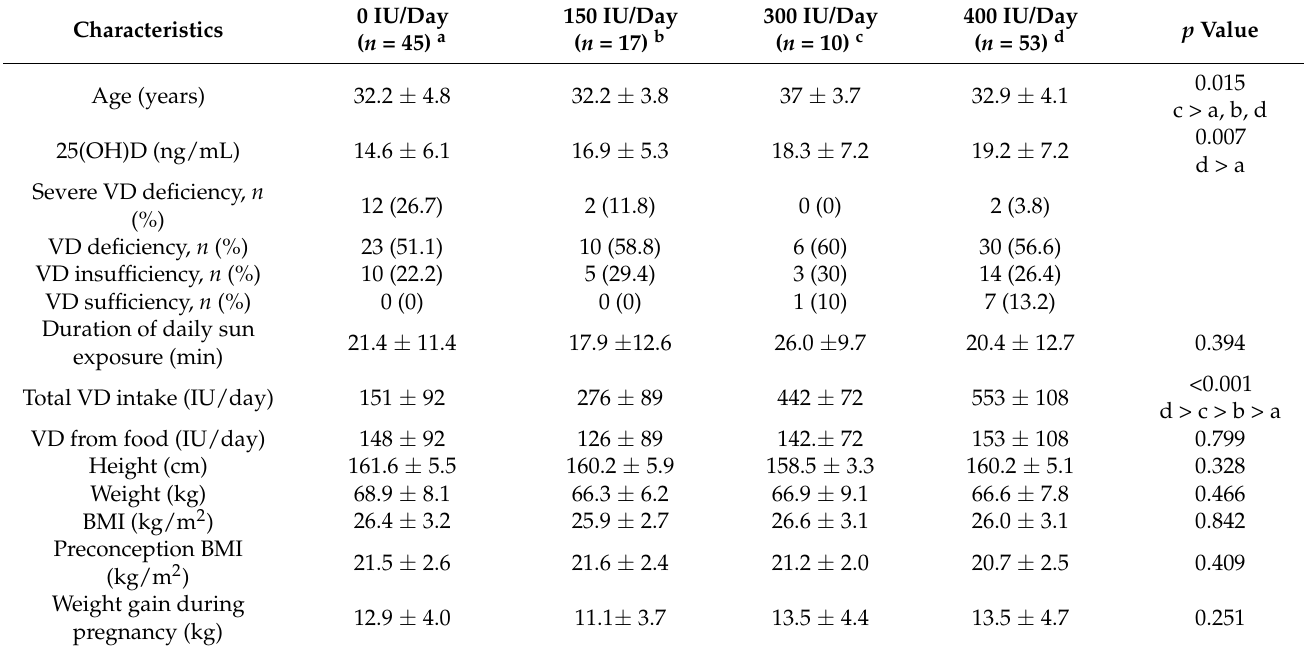
Table 4. Demographic, vitamin D status, dietary and anthropometric characteristics of the study participants stratified based on vitamin D supplementation.